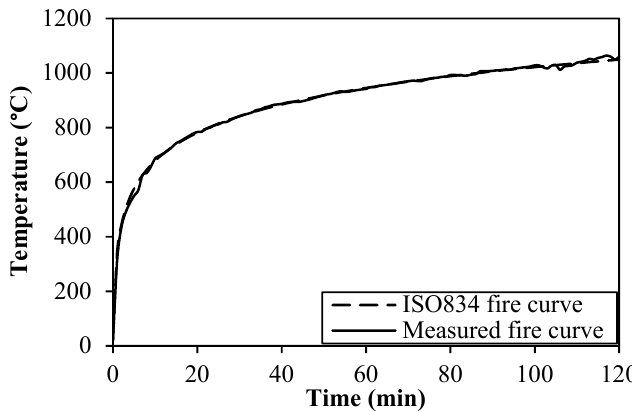
Figure 3. Time history of the recorded fire curves.